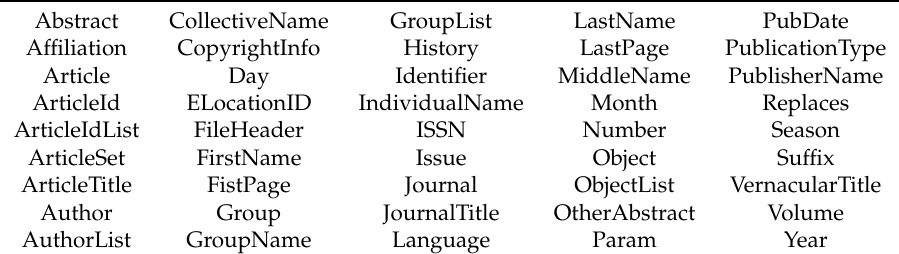
Table 2. PubMed document XML tags.